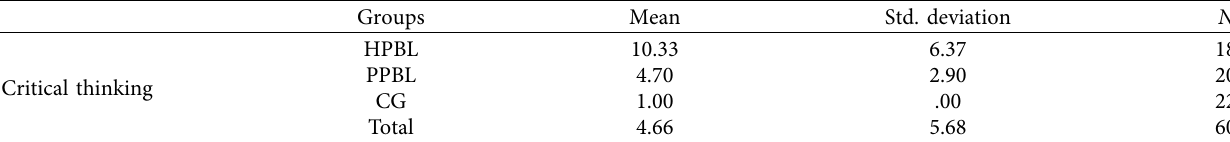
Table 9: Descriptive statistics of the learners’ critical thinking scores.